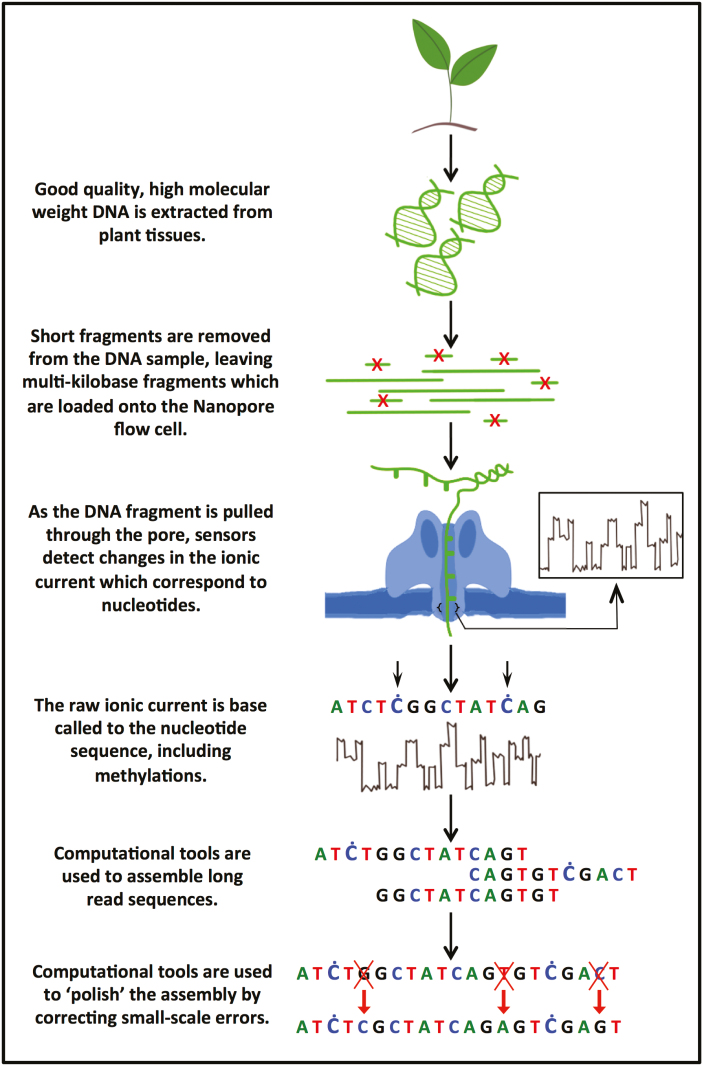
From plant tissue to genome assembly: the main steps in ONT sequencing. Optimizing each step can significantly increase the sequencing output and assembly quality.